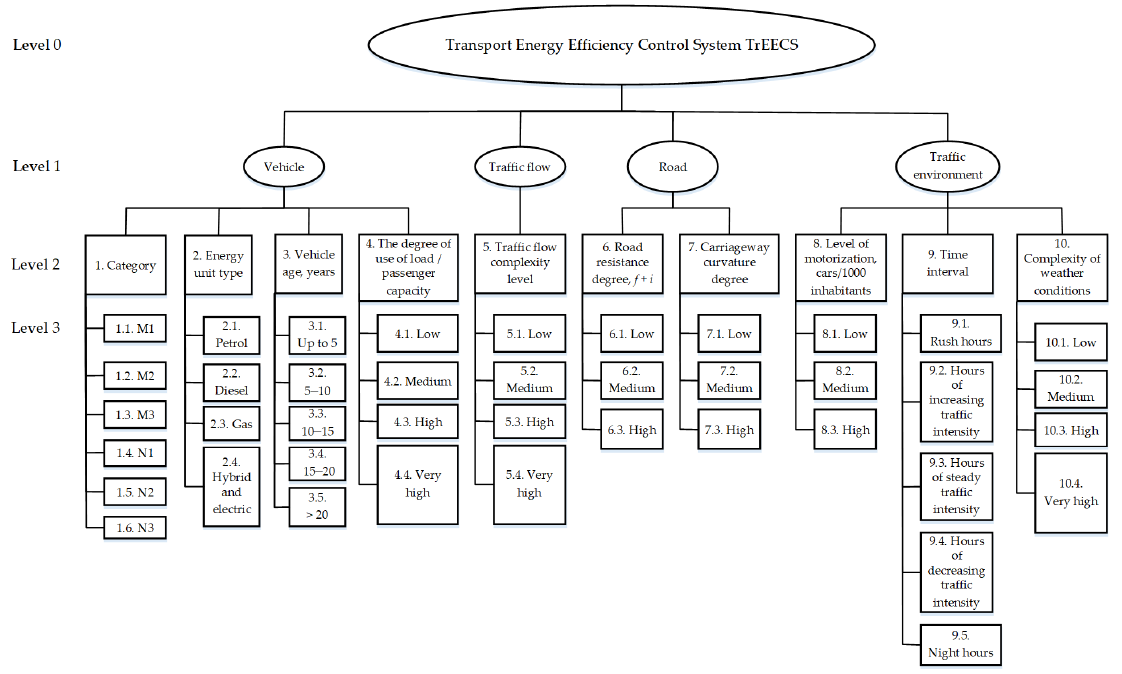
Figure 1. Structure of TrEECS.